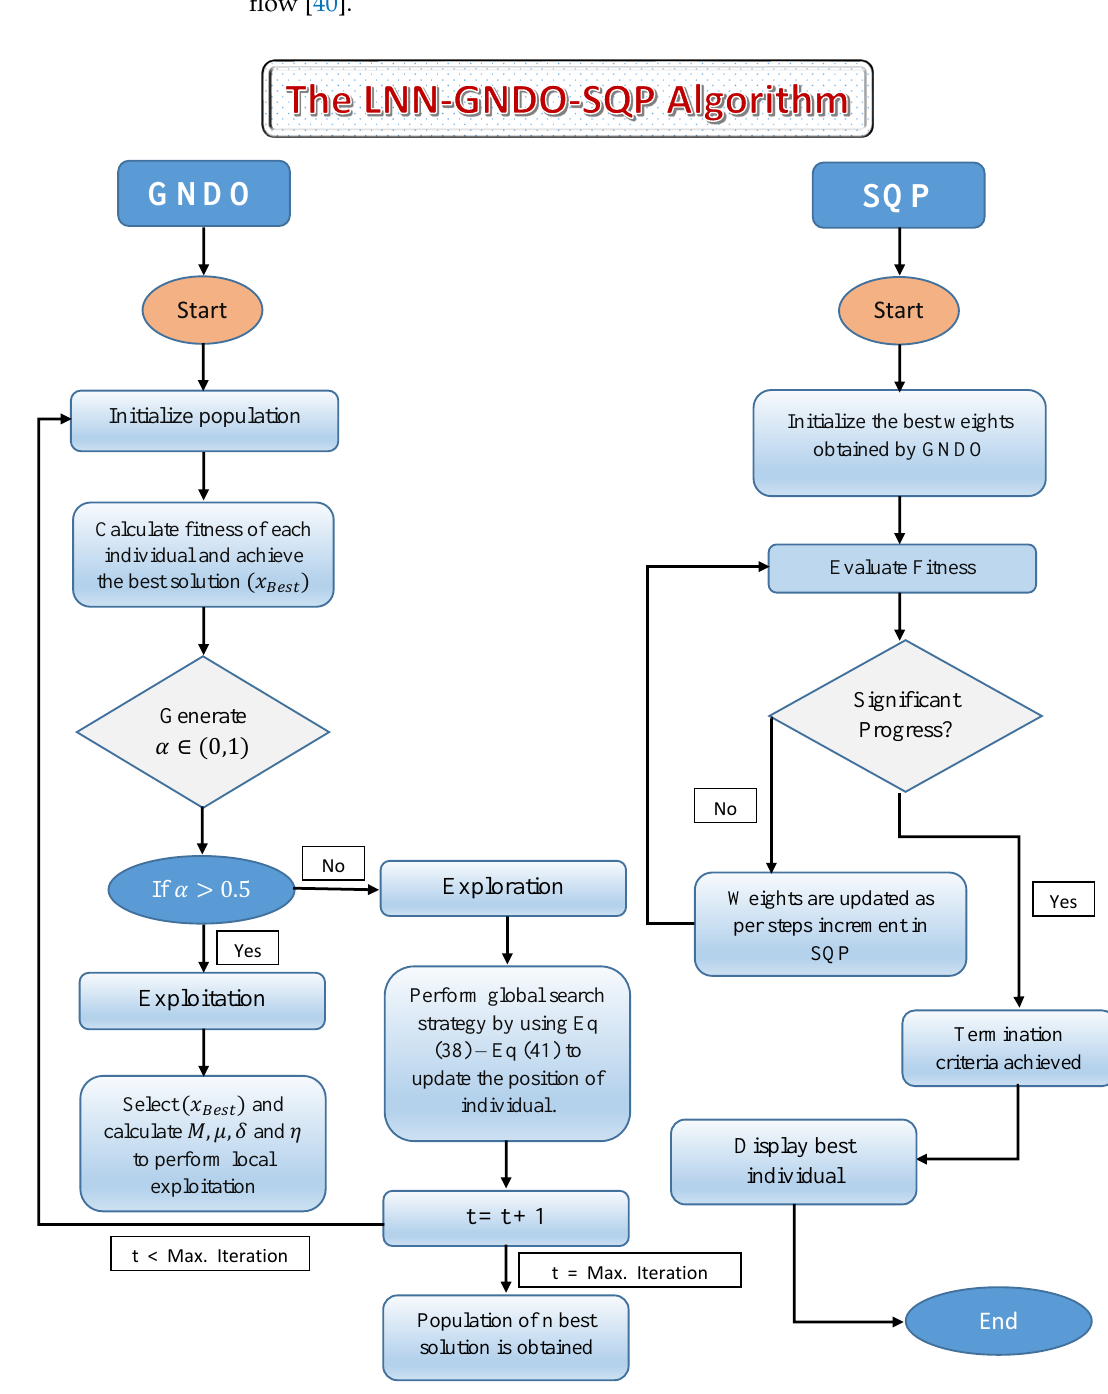
Figure 3. Flowchart of the LNN-GNDO-SQP